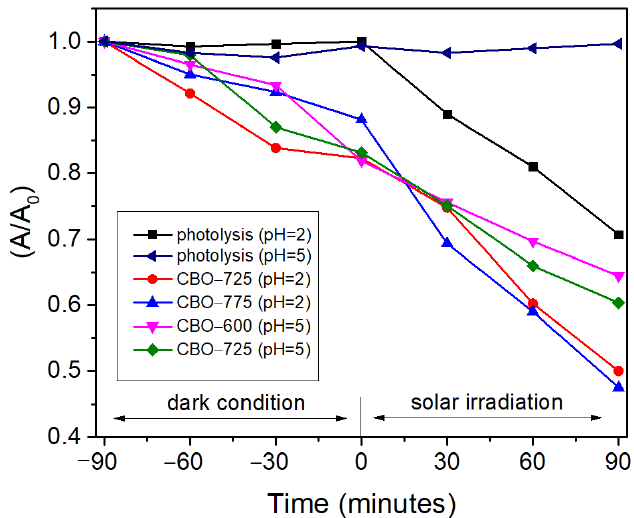
Figure 8. RhB degradation in terms of absorbance ratio for 30 mL RhB solution (of 1.5 ppm initial concentration) over CBO materials (with concentration of 1 g L −1 ) at pH = 2 and pH = 5 under continuous stirring.